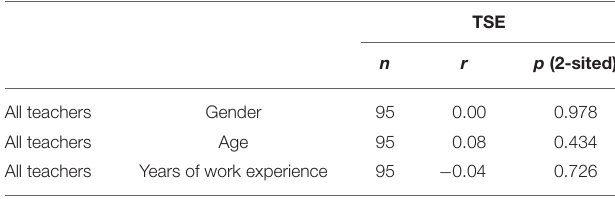
TABLE 8 | Teachers report of their TSE in distance learning. TABLE 9 | Correlations between teachers’ gender, age, years of work experience, and TSE in distance learning. n M